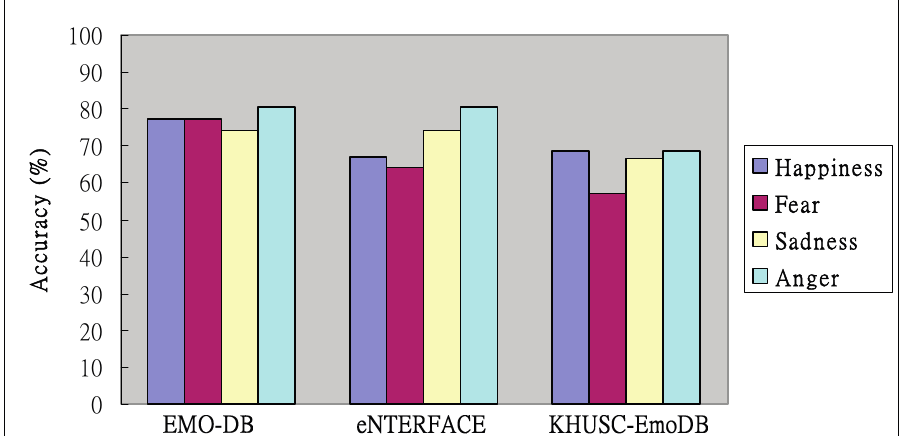
Figure 8. Evaluation of TII-based ESS on EMO-DB, eNTERFACE and